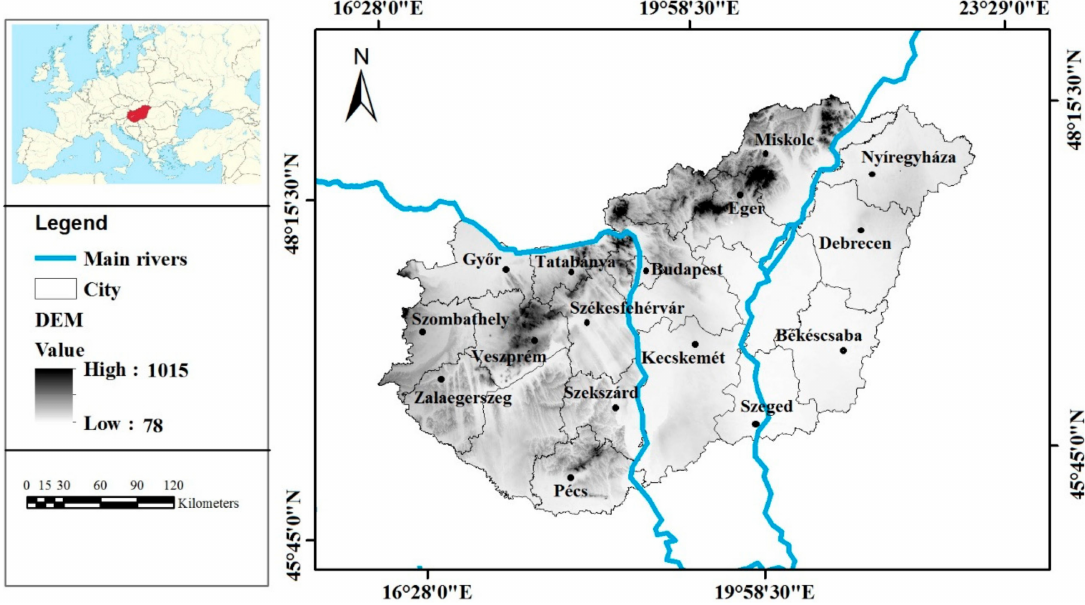
Figure 1. Location and (DEM-based) topography of the study area